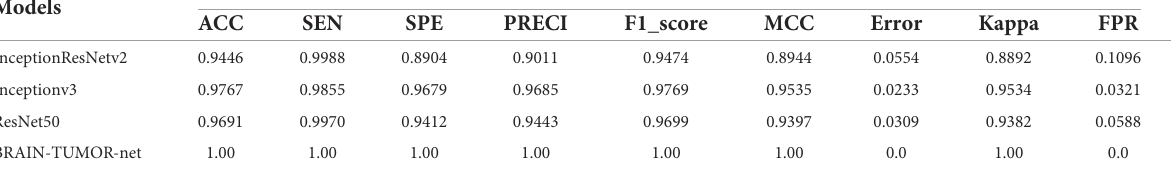
TABLE 3 Detection performance results for the proposed CNN models with a 75/25 training/testing ratio on the third dataset.